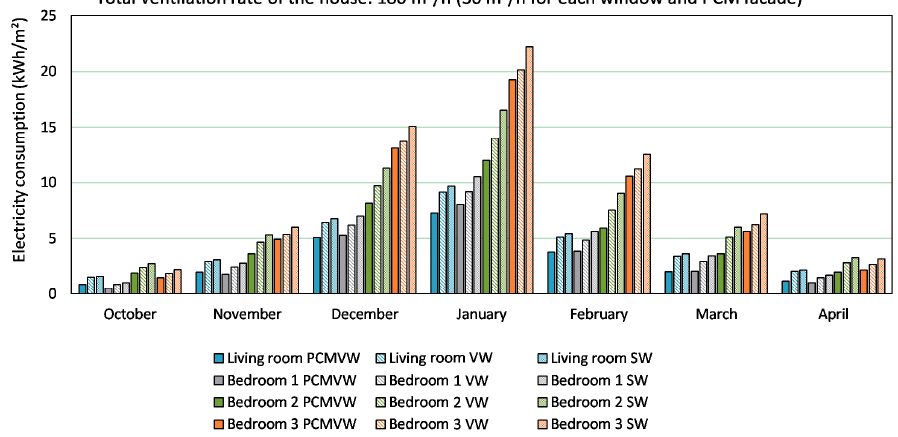
Figure 18. The electricity consumption of each room during the winter period at a ventilation airflow rate of 102 m 3 /h. Appl. Sci. 2020 , 10 , x FOR PEER REVIEW